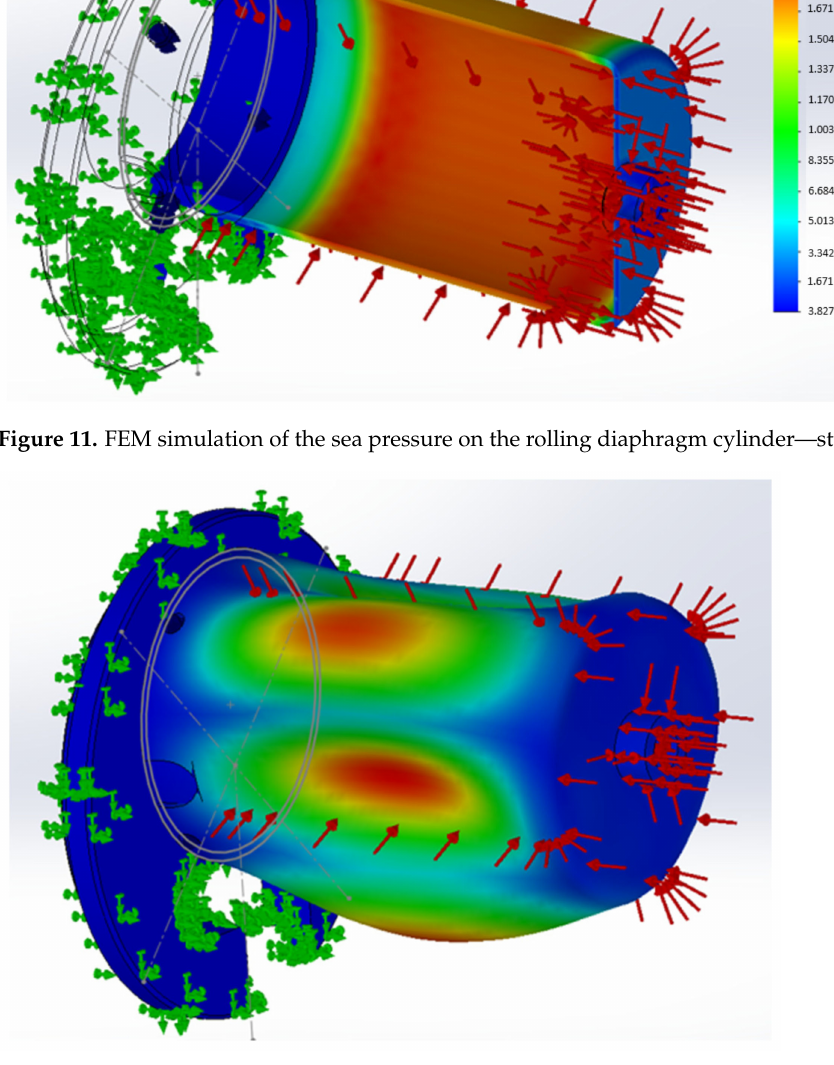
Figure 12. FEM simulation of the sea pressure on the rolling diaphragm cylinder—buckling